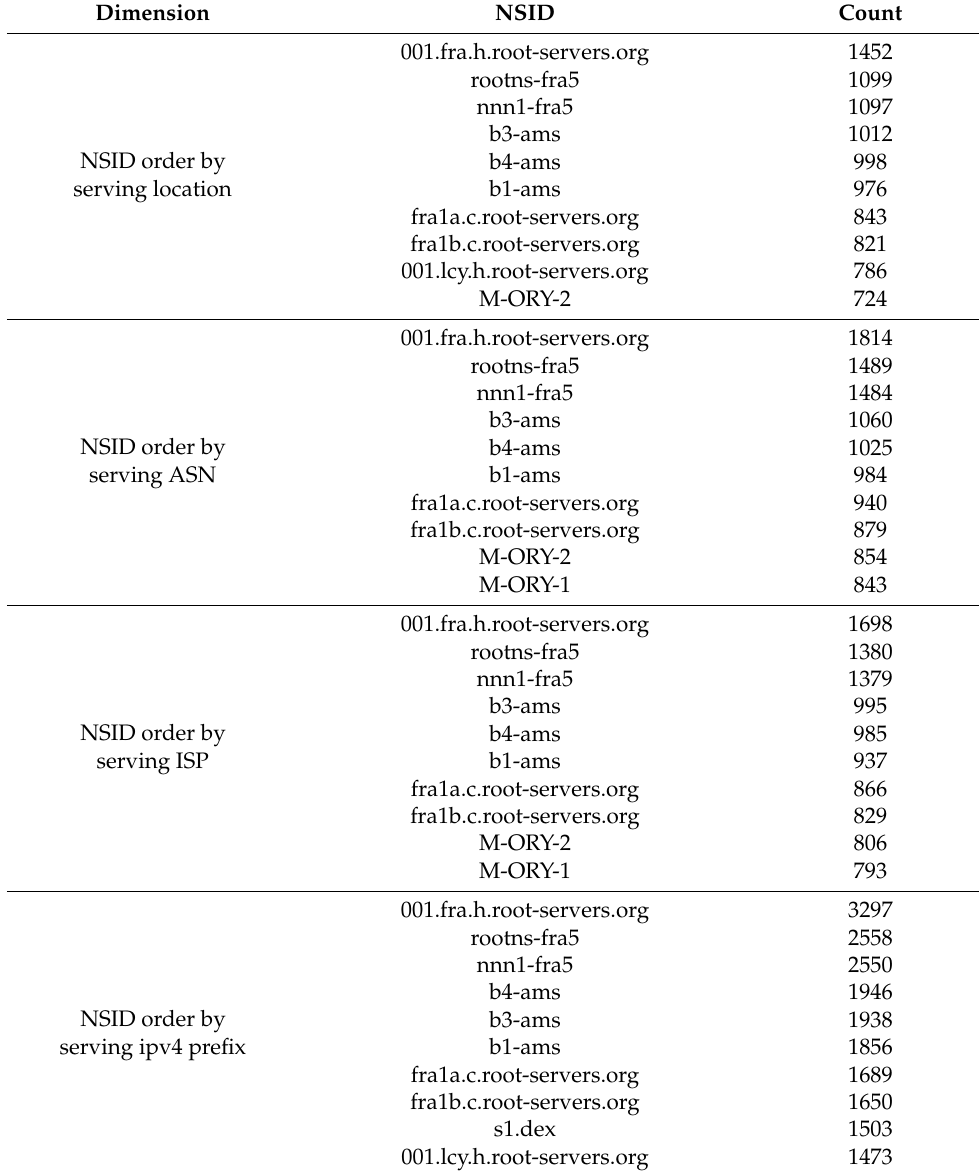
Table 3. Top 10 root mirror NSIDs for the count of services in four different dimensions.